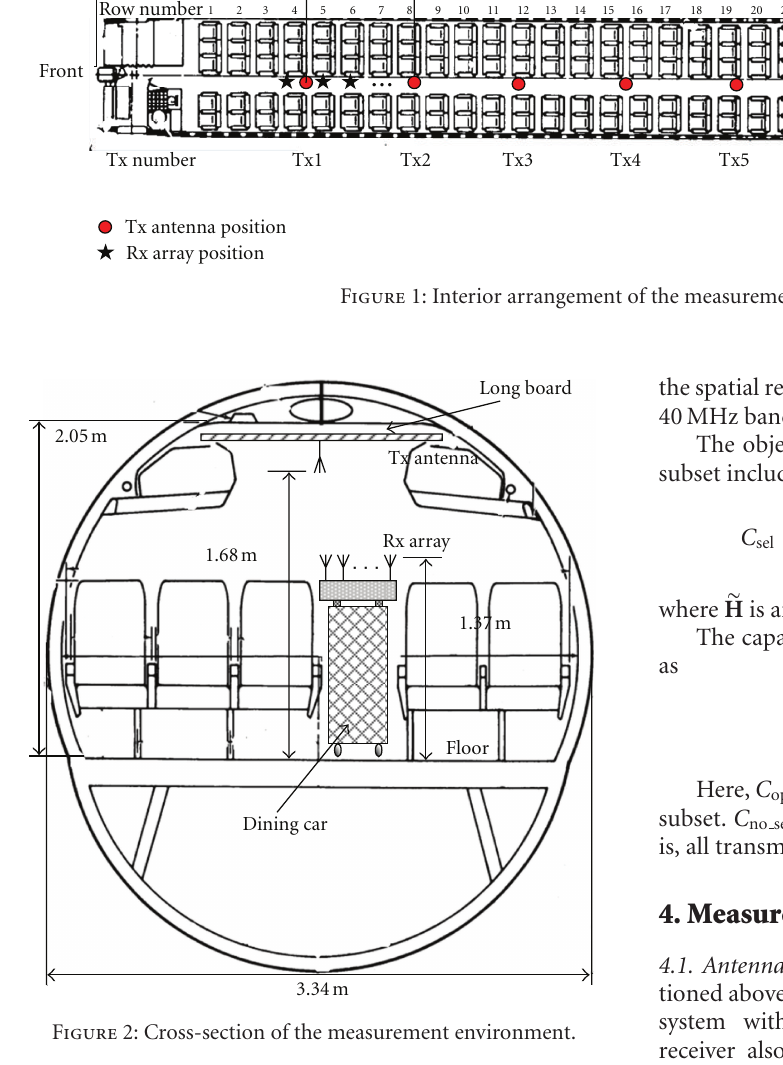
Then it is not a normalized matrix. N and M are the transmit and receive antenna numbers, respectively. I M is an M × M identity matrix. P t is the total transmit power and σ 2 is the noise power. Then ρ t = P t /σ 2 is the transmit